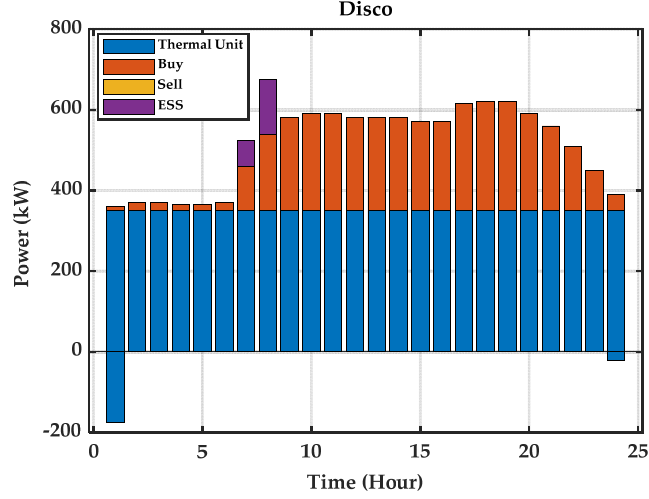
Figure 14. Load profile of Disco.